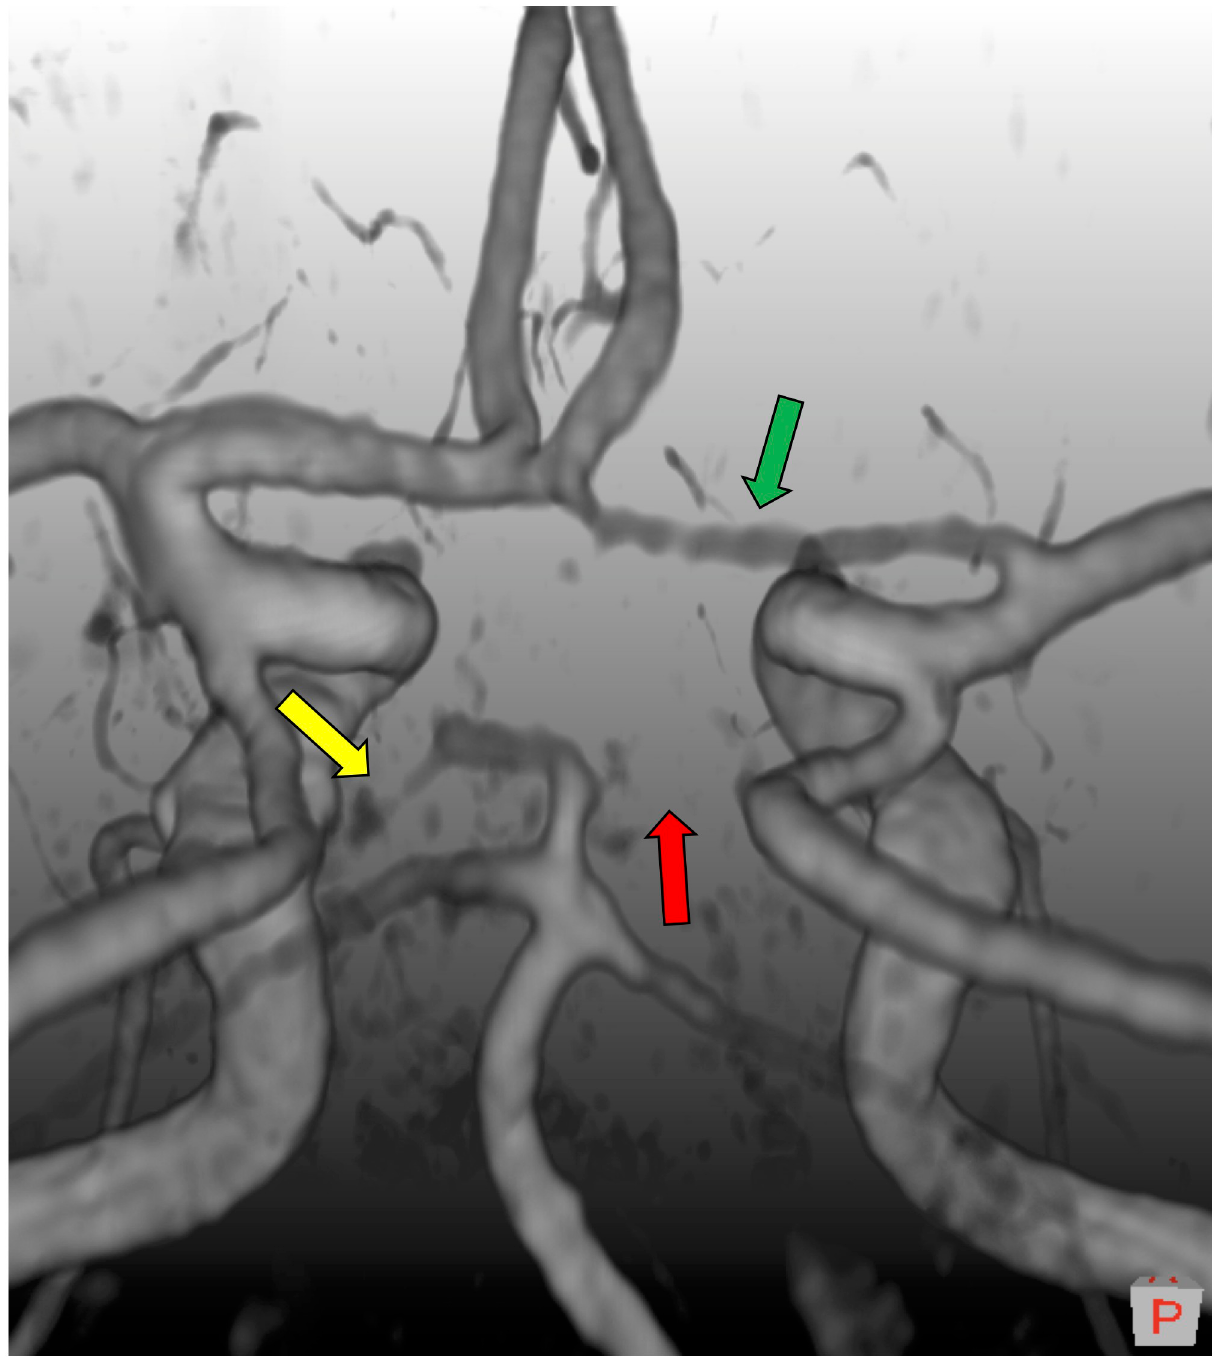
Fig 2. 3D volume rendering of a time-of-flight image depicting three classification cases within our classification scheme. Green arrow: The right anterior cerebral artery is present. Yellow arrow: The left posterior cerebral artery is hypoplastic or missing, and just below 1mm in diameter. Red arrow: The right posterior cerebral artery is clearly missing. The configuration itself is of bilateral missing posterior cerebral artery (2P) type. Image follows neurological convention, where left is left and right is right. An orientation cube in the lower right corner show orientation, and its P denotes posterior.